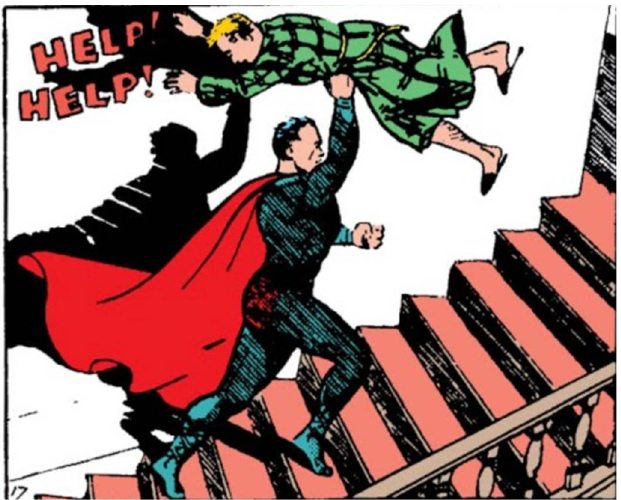
Figure 9. Joe Shuster, Superman Holds a Man over his Head (panel No. 17), 1938. Siegel and Shuster (June 1938), “Superman”, Action Comics #1 (Siegel and Shuster 1938a, p. 9). © DC Comics. Frightened villains are also seen in various panels, for example, the two villains